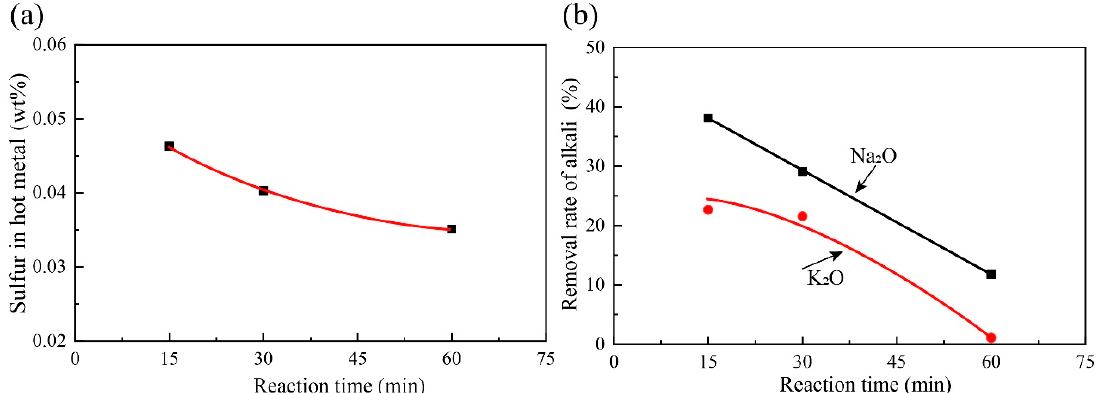
Figure 4. Effect of reaction time on the desulfurization and the removal of alkali at slag-to-metal ratio of 200 kg/t. ( a ) Desulfurization; ( b ) the removal of alkali.